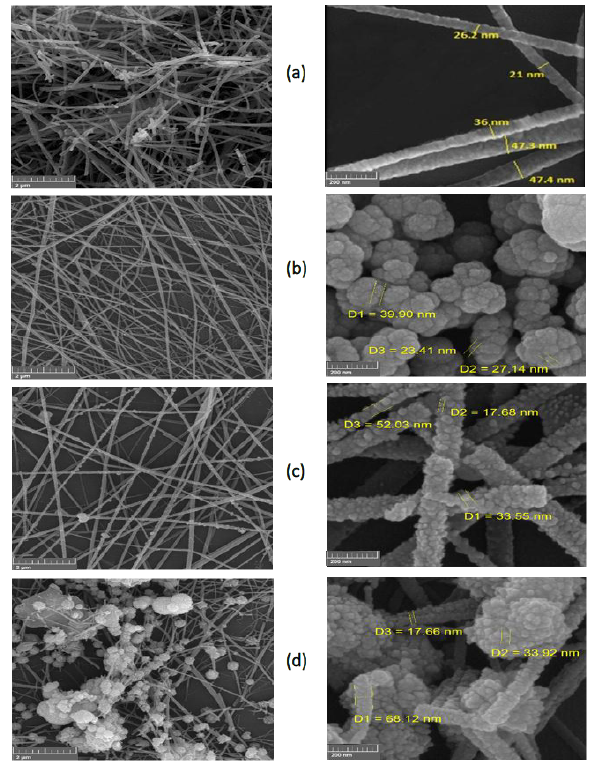
Figure 3: FESEM images of (a) pure TiO 2 nanofibers, (b) TiO 2 - 0.25CdS, (c) TiO 2 -0.5CdS, and (d) TiO 2 -1CdS composite